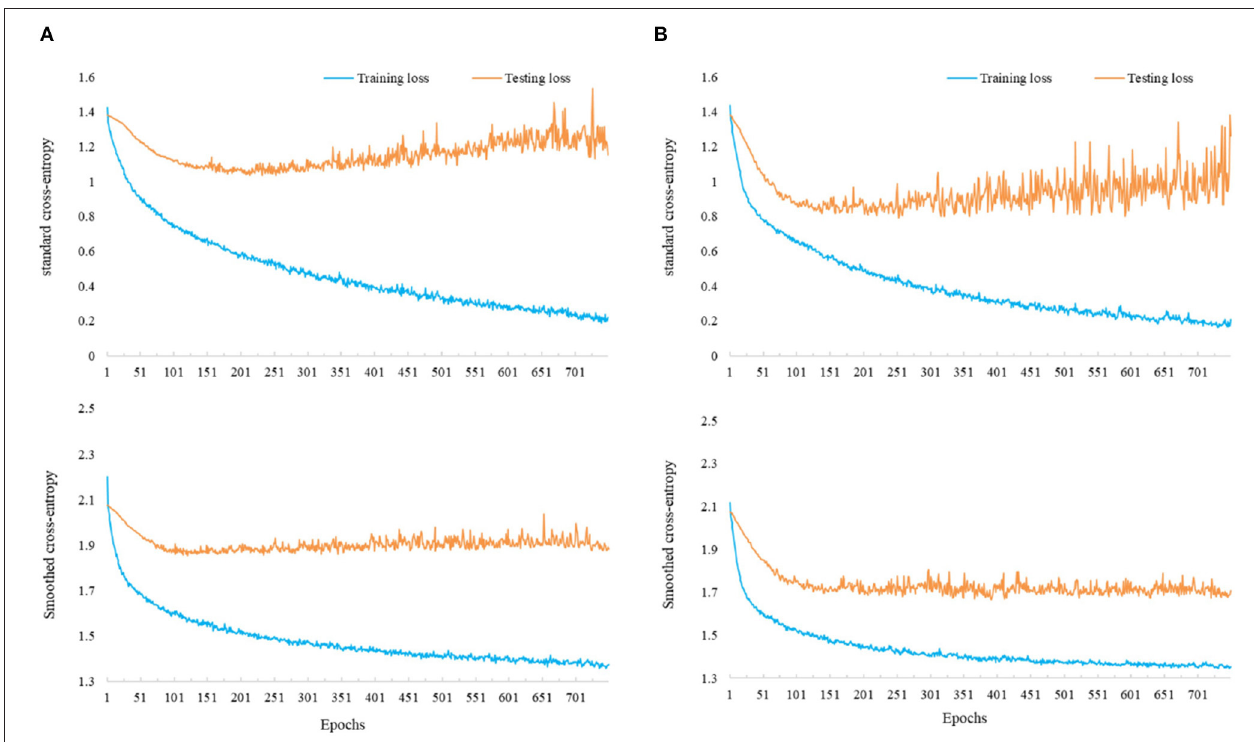
FIGURE 3 | Training and testing losses of the models using standard cross-entropy (top) and smoothed cross-entropy (bottom). (A) Learning curve of the model on A02. (B) Learning curve of the model on